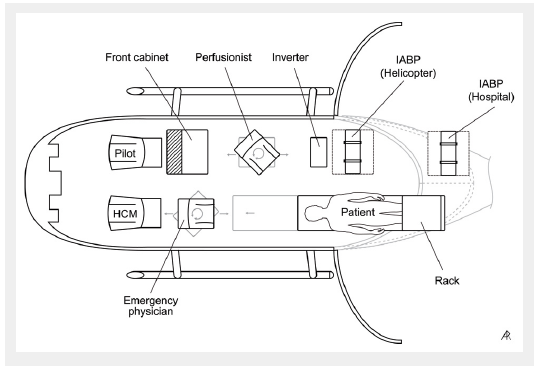
Positioning of patient, crew members and specific devices within the helicopter (back doors open). HCM: Helicopter Emergency Medical Services Crew Member; IABP: Intra-aortic balloon